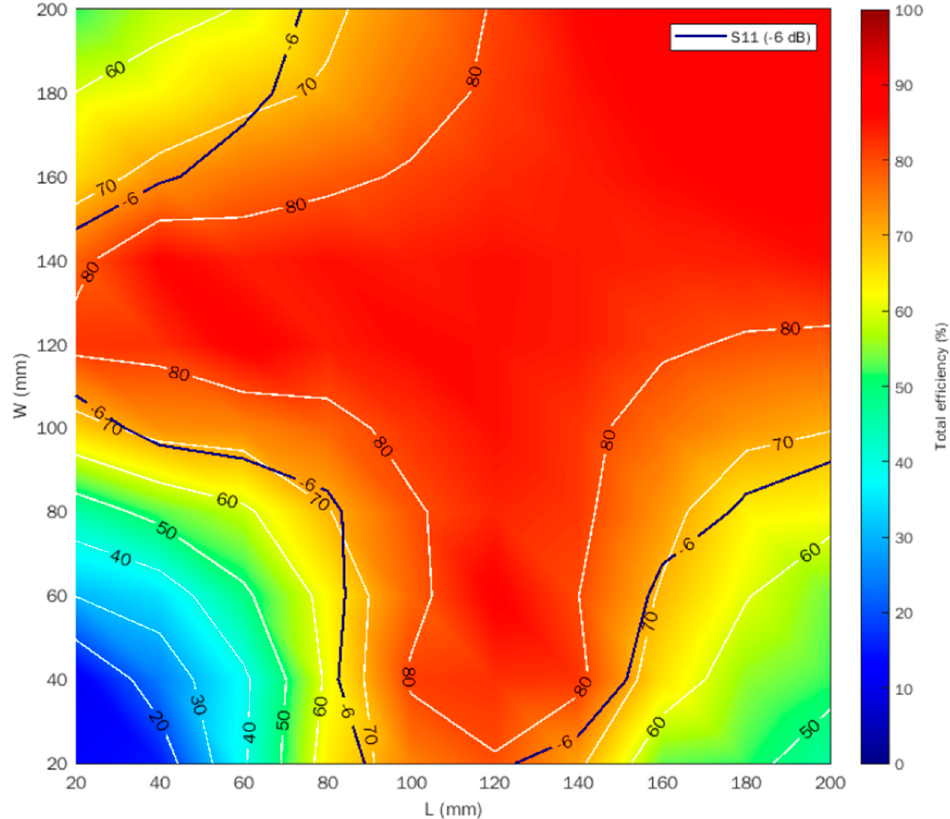
Figure 8. Simulated total efficiency for the different ground plane sizes L × W using the same 12 mm × 3 mm × 2.4 mm antenna booster and matching network for all cases. The − 6 dB contour line defines the cluster boundary of the cases with an S 11 ≤ − 6 dB across 863–928 MHz.